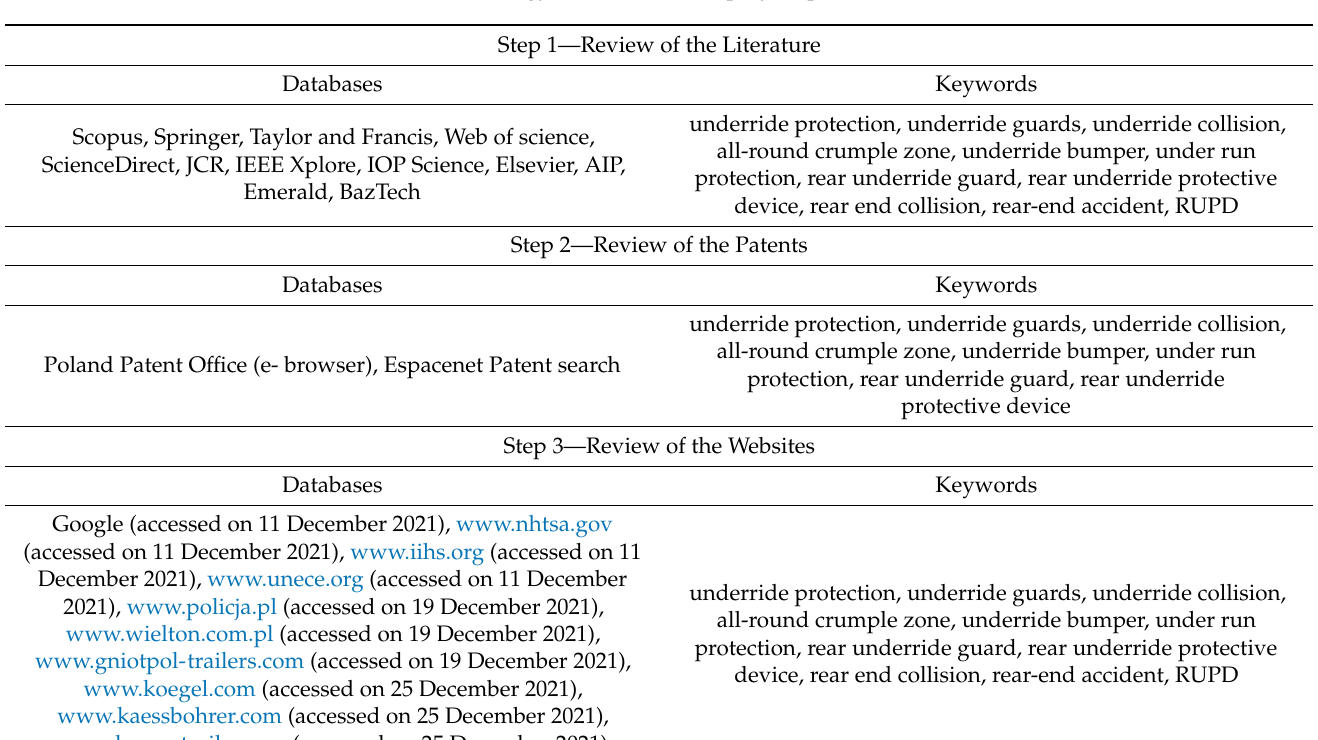
Table 2. Methodology of the review